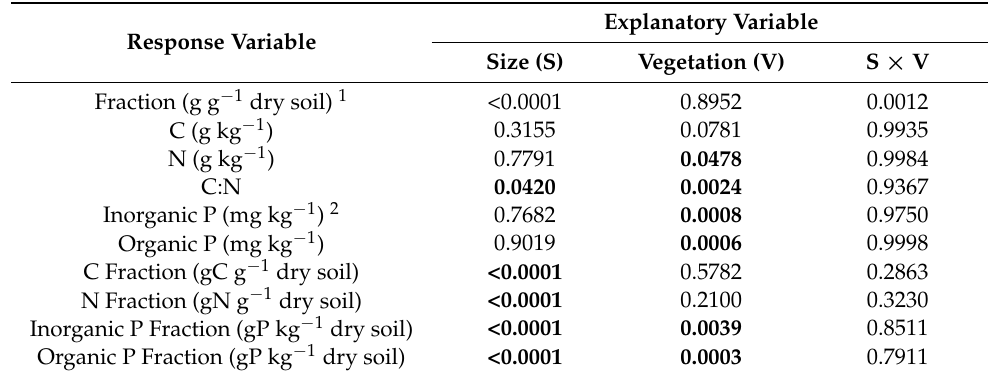
Table 1. Statistical results ( p values) for analysis of macroaggregates by size class.